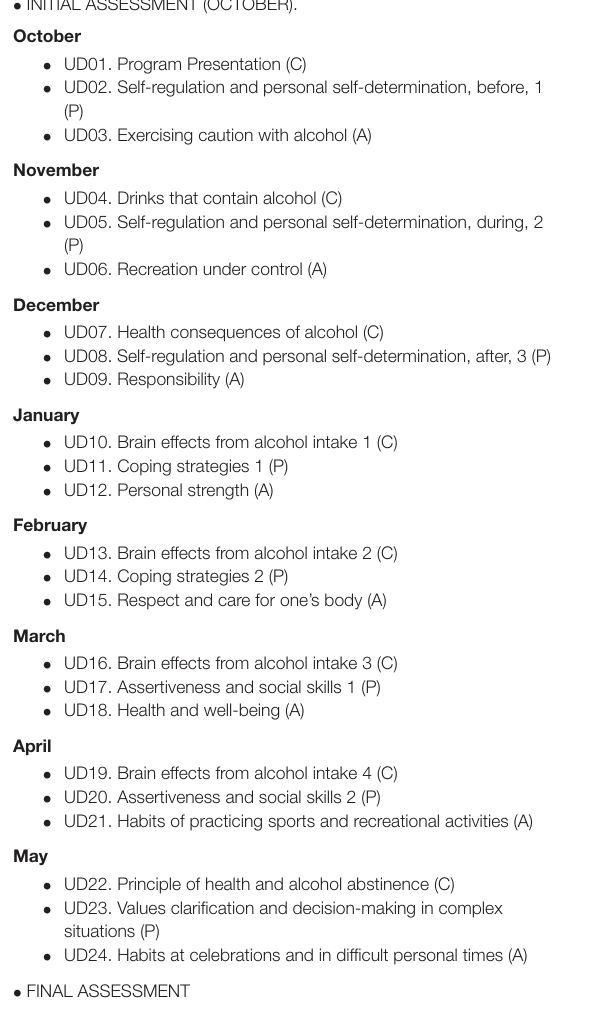
FIGURE 4 | Effects of Moment × Level of regulation on an adjusted interaction with alcohol (1 = low; 2 = medium; 3 = high).